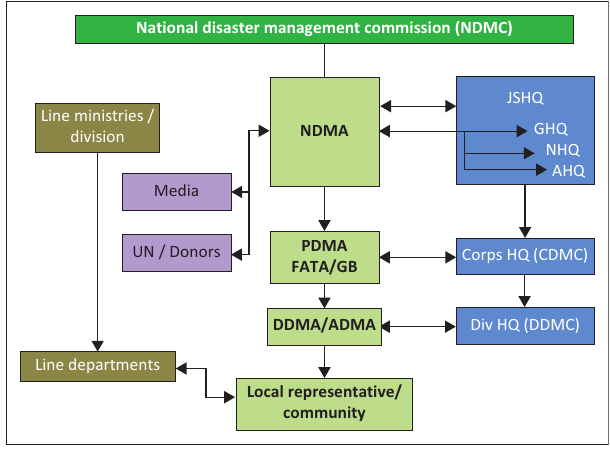
FIGURE 2 : National disaster management layout: Key players/stakeholders.